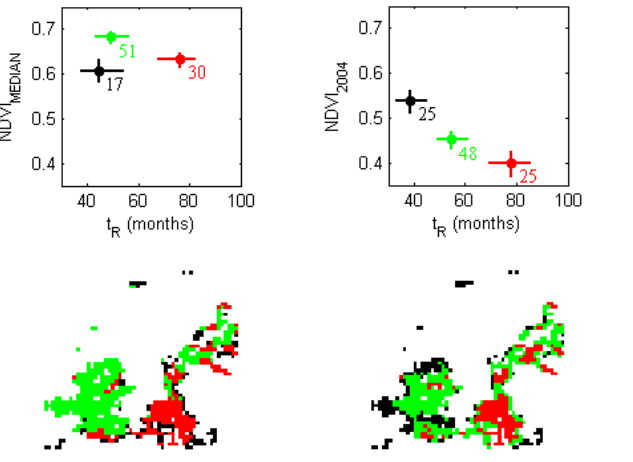
Fig. 9. As in Fig. 8, but with respect to the large fire scar located in Region